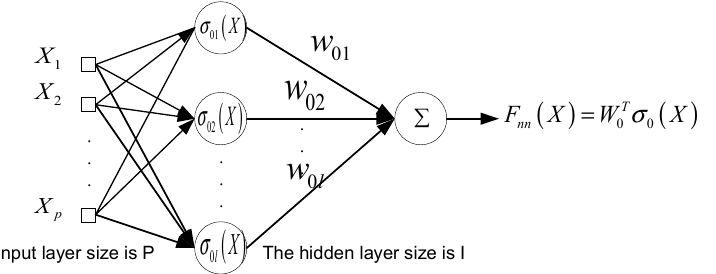
Figure 2. Schematic diagram of RBFNN working principle.